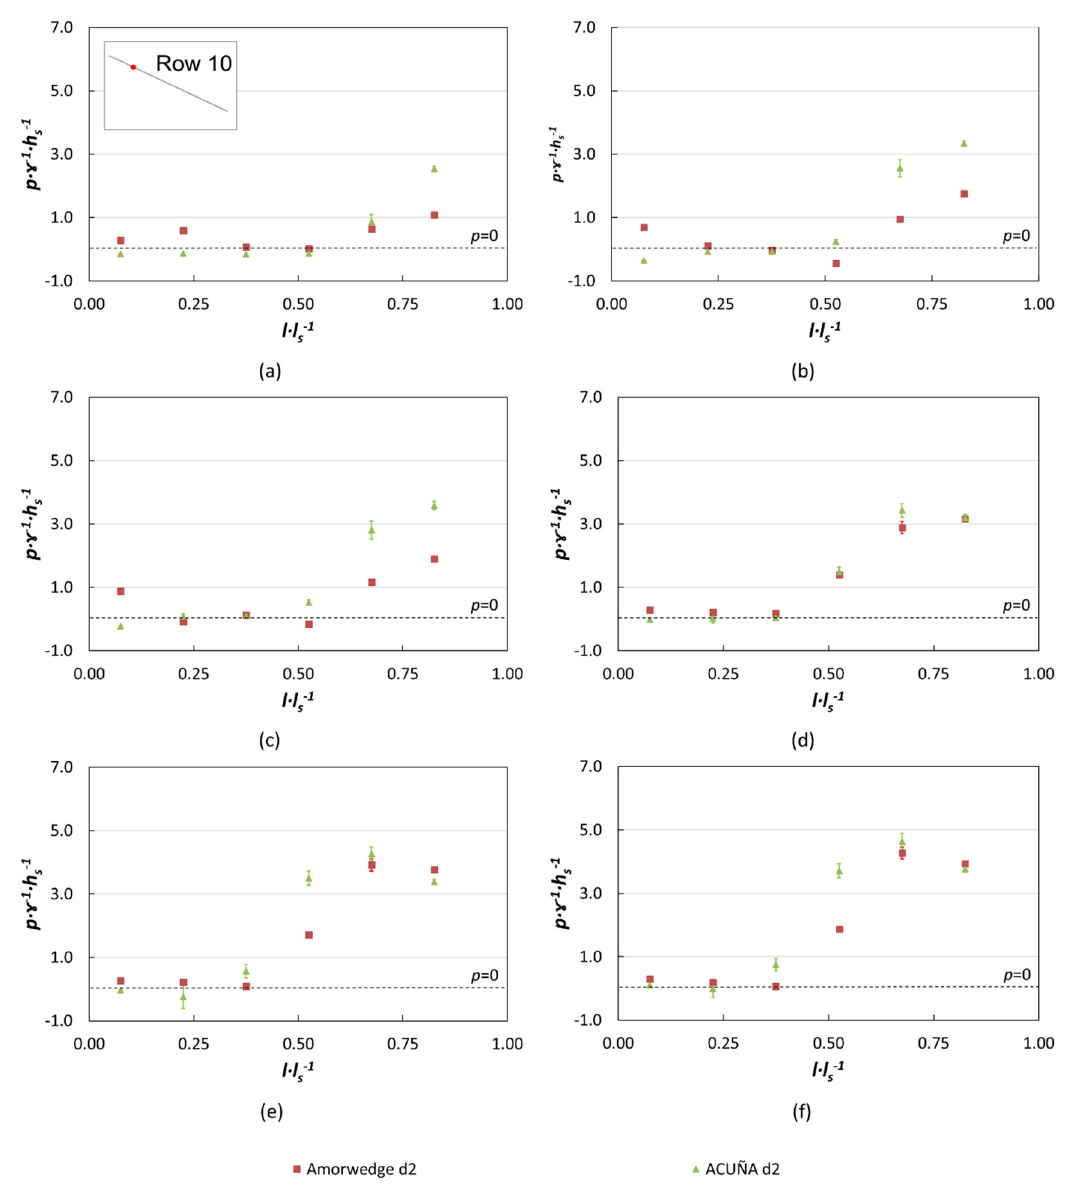
Figure 15. Average and standard deviation of the hydrodynamic pressures registered on the tread of the Armorwedge TM ( w 1) and ACUÑA ( w 2) block in row 10 of the chute for different unit discharges simulating the blocks laid over an impervious soil with an intermediate and permeable bedding granular layer ( d 2): ( a ) 0.04 m 2 s − 1 , ( b ) 0.08 m 2 s − 1 , ( c ) 0.10 m 2 s − 1 ,